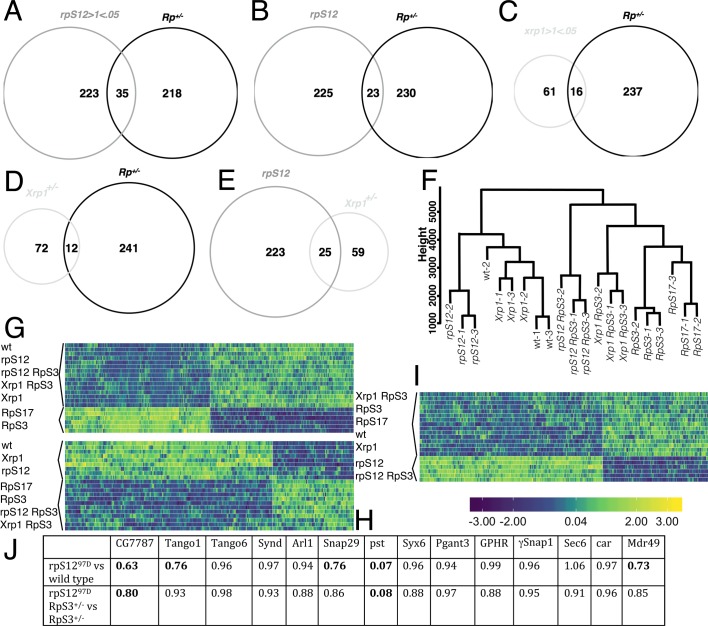
Cross-genotype co-expression analysis.A. Transcripts that differed significantly between control and rpS12D97/D97 wing discs showed little overlap with those affected in RpS3+/- and RpS17+/- wing discs. B) Transcripts dependent on RpS12 in both Rp+/- and Rp+/+ wing discs showed little overlap with those affected in both RpS3+/- and RpS17+/- wing discs. C) Transcripts that differed significantly between control and Xrp1+/- wing discs showed little overlap with those affected in RpS3+/- and RpS17+/- wing discs. D) Transcripts dependent on Xrp1 in both Rp+/- and Rp+/+ wing discs showed little overlap with those affected in both RpS3+/- and RpS17+/- wing discs. E) RpS12- and Xrp1-dependent transcripts showed little overlap. F) Hierarchical clustering of wing disc samples by their similarities (as Pearson correlation coefficients) in gene expression profiles distinguished samples by genotypes. The Xrp1+/- replicates grouped with wild type controls. G) Co-expressed and similarly-regulated genes (module #2) whose expression was altered in RpS3+/- and RpS17+/- wing discs in an RpS12-dependent, Xrp1-dependent manner. H) Co-expressed and similarly-regulated genes (module #8) whose expression was altered in RpS3+/- and RpS17+/- wing discs in an RpS12-independent, Xrp1-independent manner. I) Co-expressed and similarly-regulated genes (module #6) whose expression was altered in an RpS12-dependent manner regardless of RpS3 genotype. In G-I, the columns in the heatmaps are genes and the rows are samples (3 replicates each as indicated); color scale indicates relative expression across samples. J) Genes in the Module 6 that were downregulated in rpS12D97 genotypes and present in the GO term ‘secretion’. Their fold changes (from DESeq2) are shown here. Bold values were statistically significant (Padj < 0.05). Neither Module 6 genes that were upregulated in rpS12D97 genotypes, not Module 6 as a whole, was enriched for any particular GO terms.